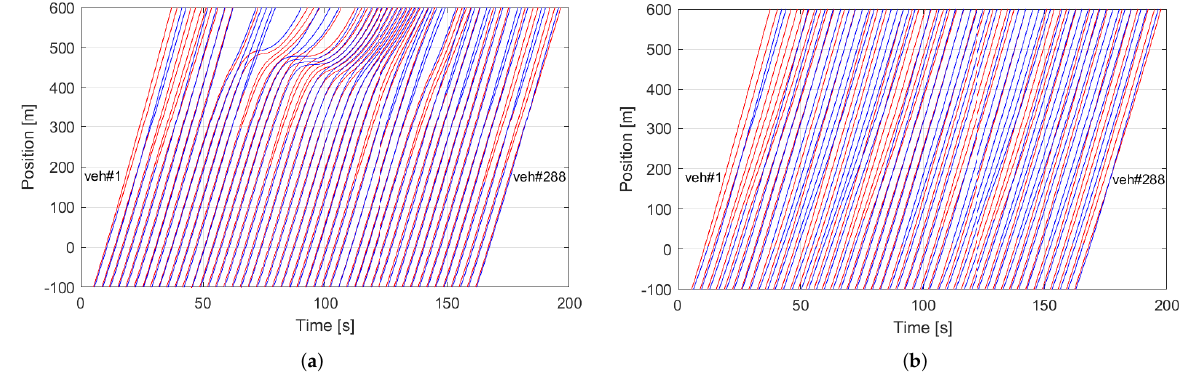
Figure 5. Trajectories of the vehicles traveling about 600 m in 200 s on the model multi-lane freeway. The sub-figures show ( a ) the traditional driving system and ( b ) the proposed traffic coordination system.